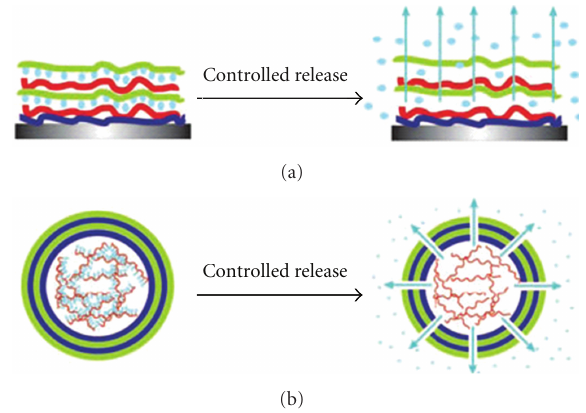
Figure 12: Schematic illustration of the entrapment/release of active materials: (a) Active material is embedded in the “passive” matrix of the coating; (b) active material is encapsulated into nanocontainers with a shell possessing controlled permeability properties.